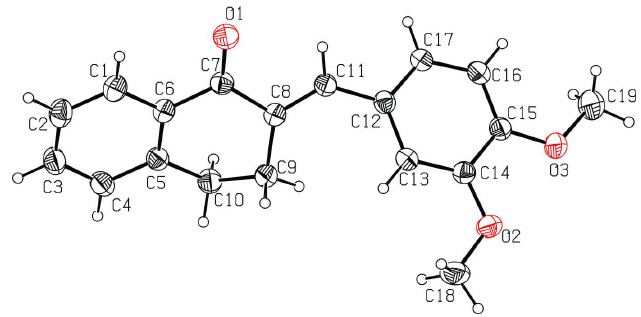
Figure 1 The molecular structure of the title compound, showing the atom labelling. Displacement ellipsoids are drawn at 30% probability level. Hydrogen atoms are shown as arbitrary